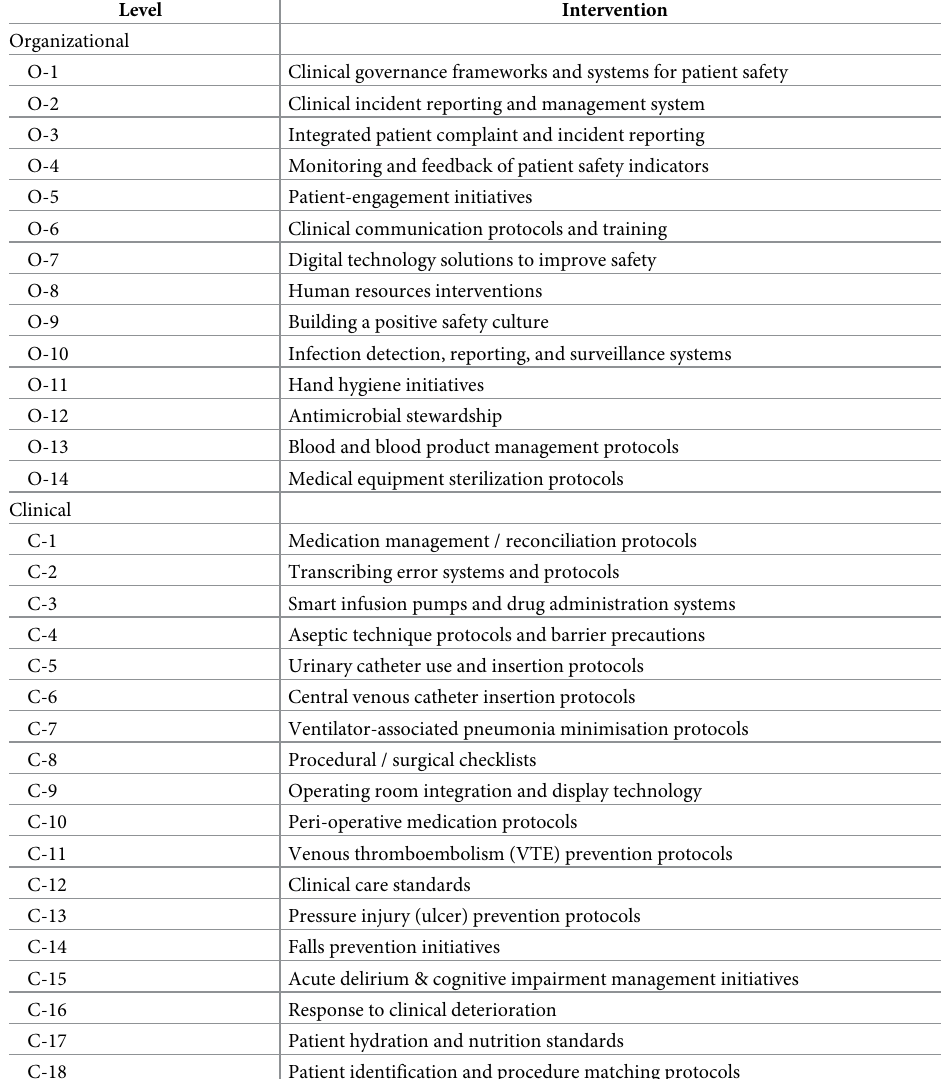
Table 1. Patient safety